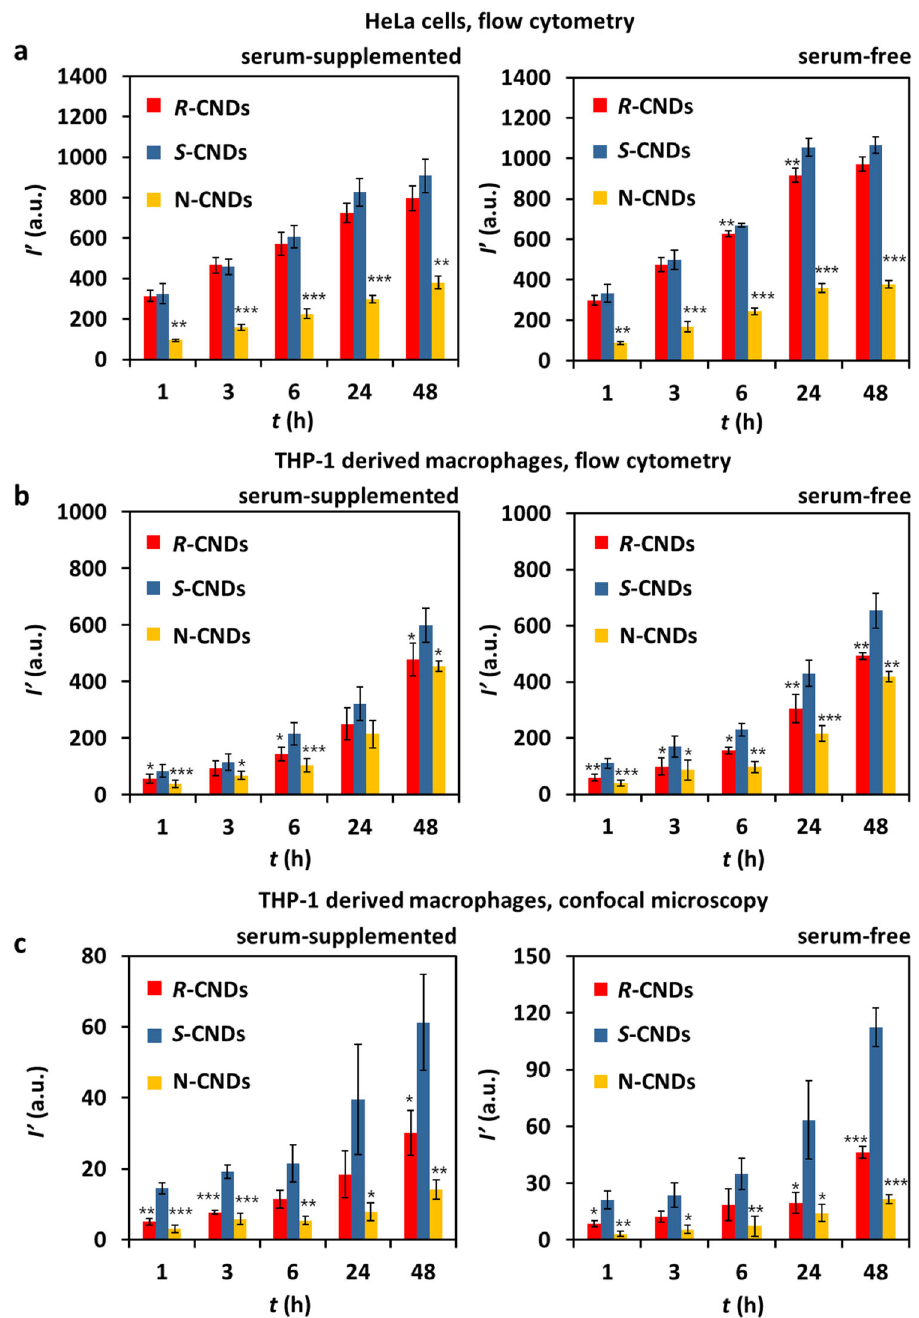
Fig. 3 Uptake of CNDs as quanti fi ed by the mean CND fl uorescence I ′ per cell. Cells were incubated for different times t at a CND concentration of C ′ Fig. 22. b THP-1 derived macrophages, I ′ detected by fl ow cytometry, see also Supplementary Fig. 24. c THP-1 derived macrophages, I ′ detected by confocal microscopy, see also Supplementary Fig. 12. Results are shown as mean value ± standard deviation (s.d.) from three independent samples ( n = 3) over three independent experiments. P values were analyzed by Student ’ s t test with two-tailed distribution and two-sample equal variance. * P < 0.05, ** P < 0.01, *** P <